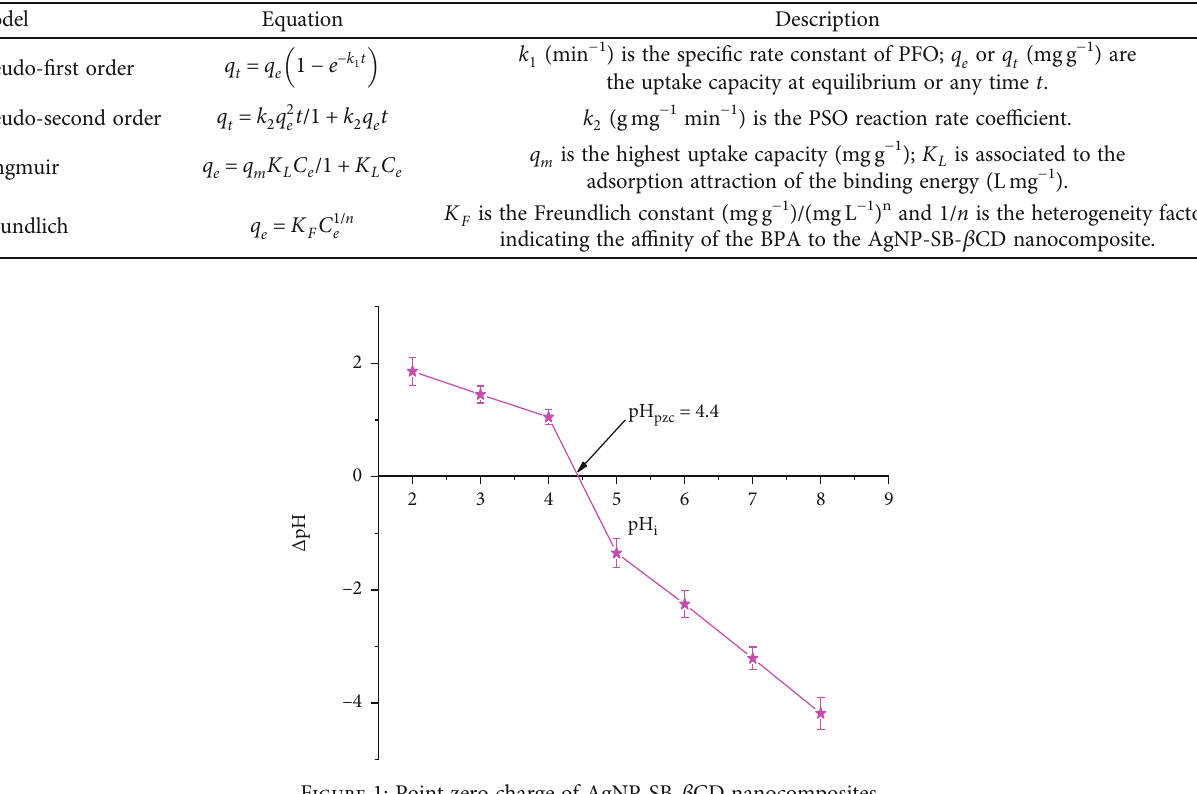
Table 1: The expressions of isotherm and kinetic models applied to examine the uptake of bisphenol A onto AgNP-SB- β CD